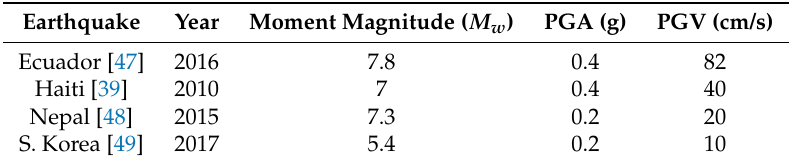
Table 1. Properties of the selected earthquakes.